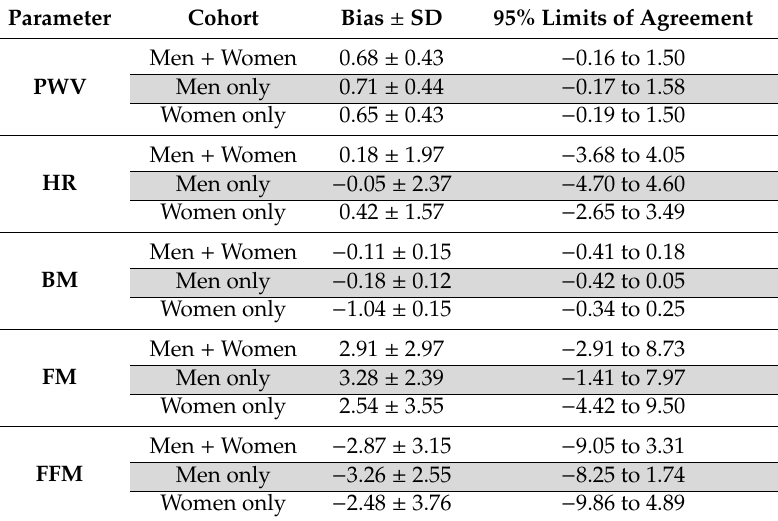
Table 1. Altman statistical analyses.